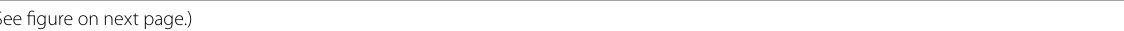
figure on next Fig. 1 Callose in different tissues of plants following inoculation with SMV. A Fluorescence from stained callose in leaf vein of Wuxing 2 frictionally inoculated with N3; B micrograph of A under transmission light; C Fluorescence from stained callose in petiole of Wuxing 2 frictionally inoculated with N3; D micrograph of C under transmission light; E callose was not detectable in stem of Wuxing 2 frictionally inoculated with N3; F micrograph of E under transmission light; G callose was not detectable in vein of Wuxing 2 simulating inoculated; H micrograph of ( G ) under transmission light; I callose was not detectable in petioles of Wuxing 2 simulating inoculated; J micrograph of ( I ) under transmission light; K: callose was not detectable in stems of the Wuxing 2 inoculated with water; L micrograph of K under transmission light; a, c, e, g, i, k: enlarged pictures of the areas labelled with the arrows in picture ( A , C , E , G , I , K